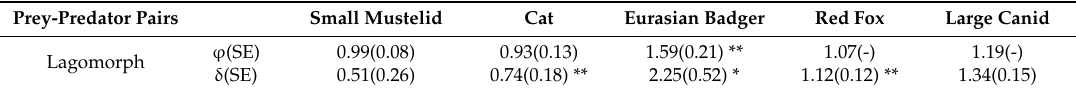
Table 4. Parameters of interspecific interactions between lagomorphs and predators representing the deviation from randomness of the probability of species co-occurrence in a crossing structure ( ϕ ) or on a given day ( δ ). Standard errors are given in parentheses, except where not computed due to a lack of variability at some passage types. * p < 0.05 and ** p <